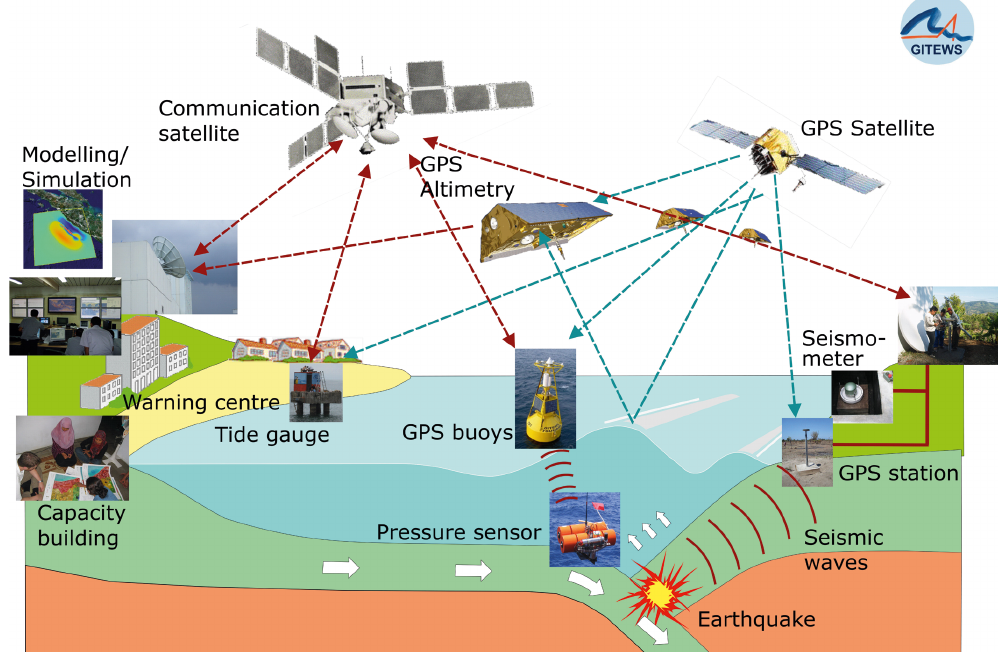
Fig. 2. Different sensor systems used within the Indian Ocean warning system. All data are transmitted via satellite to the warning centre. Besides the early warning system itself, the project also includes capacity building for Indonesian institutions, local authorities and the